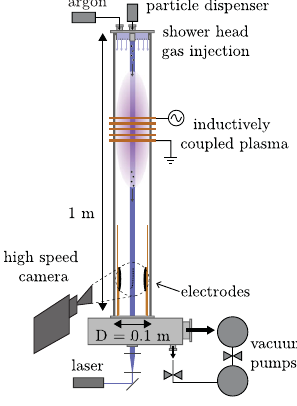
Fig. 5 Schematic drawing of the experimental setup. Schematic drawing of the PPCI setup. Clustered microparticles traveled through a spatially limited region of plasma. The particle charge was measured at the bottom of the tube by accelerating the particles in an externally applied electric fi eld. Figure adapted from https://doi.org/10.1088/1361-6595/ab8e4f, IOP Publishing. Reproduced with permission. All rights reserved.